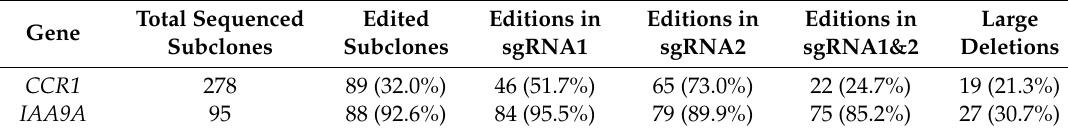
Table 2. Editing frequency and position (identified by PCR subcloning and subsequent